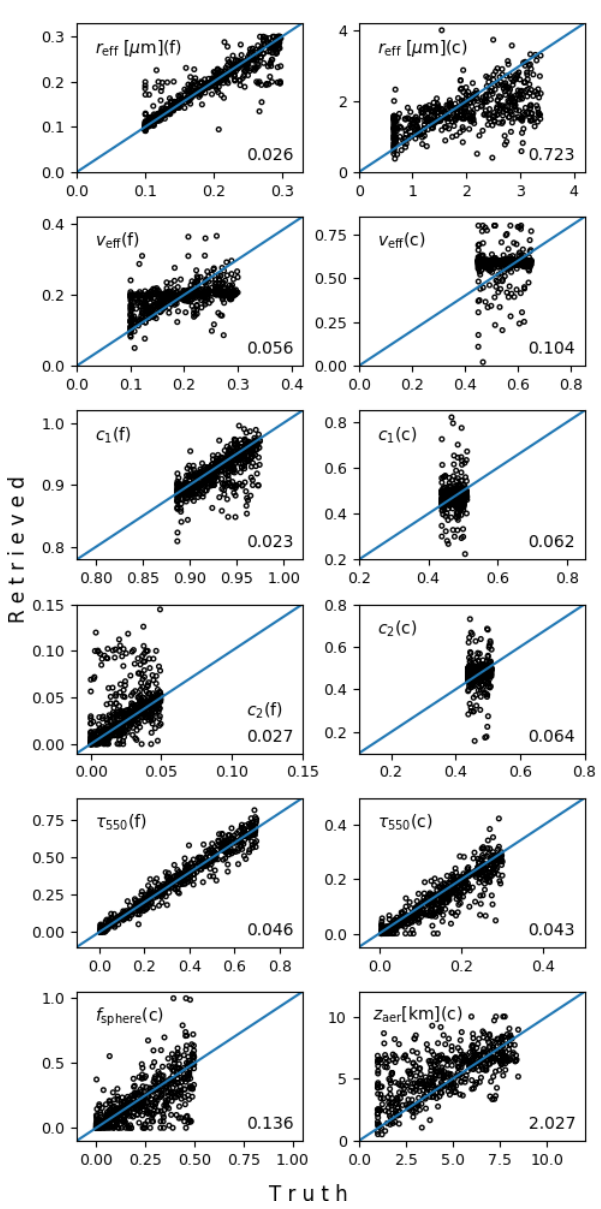
Figure B2. Aerosol properties retrieved using MAP-only measure- ments compared to the truth. In each panel, the letter “c” or “f” in parentheses behind the aerosol variable name indicates the aerosol mode, i.e. coarse or fine. The RMSE for each parameter is given in the bottom right corner. τ 550 is the aerosol optical depth at 550nm. The diagonal solid lines outline the one-to-one correspondence.